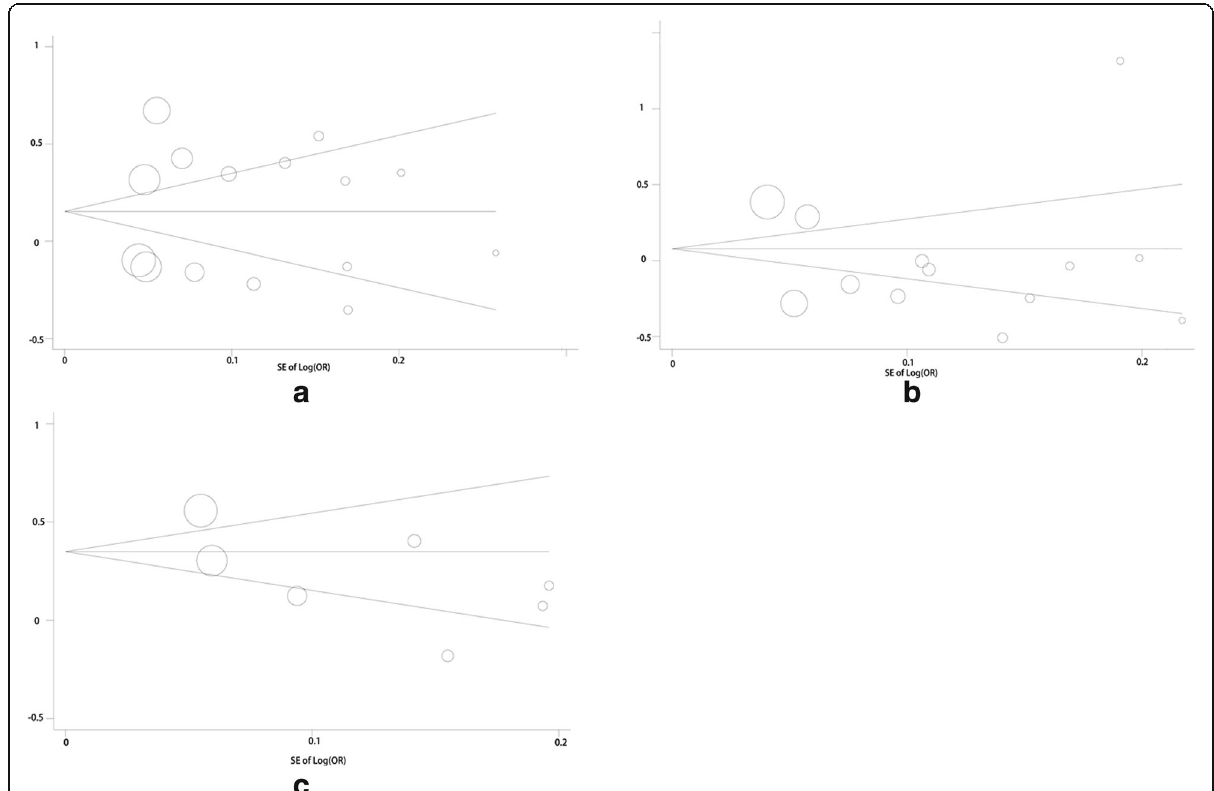
Fig. 6 Funnel plots of 3 SNPs: a . funnel plot in rs965513, b . funnel plot in rs944289, c . funnel plot in